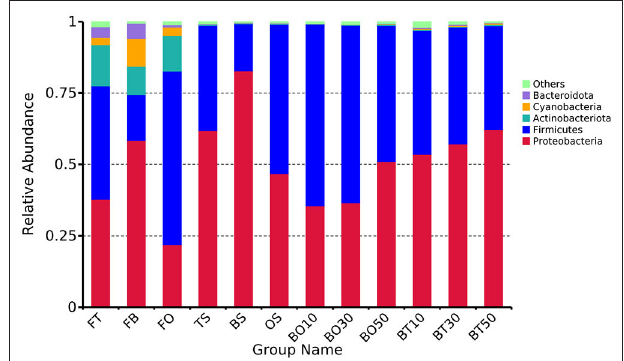
FIGURE 2 | Relative abundance of bacteria at the genus level. FT, fresh forage wheat; FB, fresh faba bean; FO, fresh oat; BS, 100% faba bean silage; OS, 100% oat silage; TS, 100% forage wheat silage; BO10, 10% faba bean with 90% oat mixed silage; BO30, 30% faba bean with 70% oat mixed silage; BO50, 50% faba bean with 50% oat mixed silage; BT10, 10% faba bean with 90% forage wheat mixed silage; BT30, 30% faba bean with 70% forage wheat mixed silage; BT50, 50% faba bean with 50% forage wheat mixed